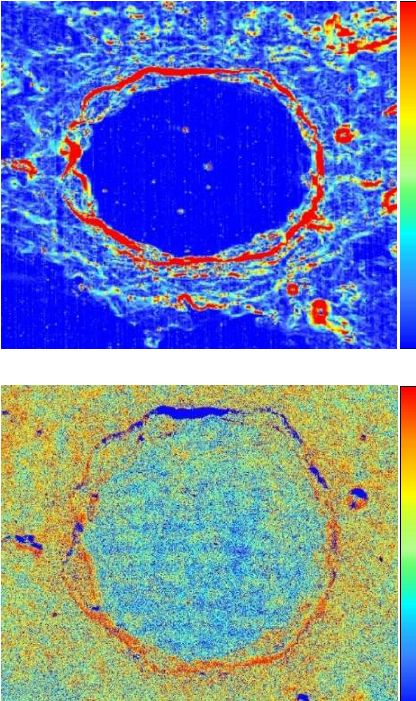
Figure 7. Results by using RMSH (up) and MSR (down) of Crater Plato